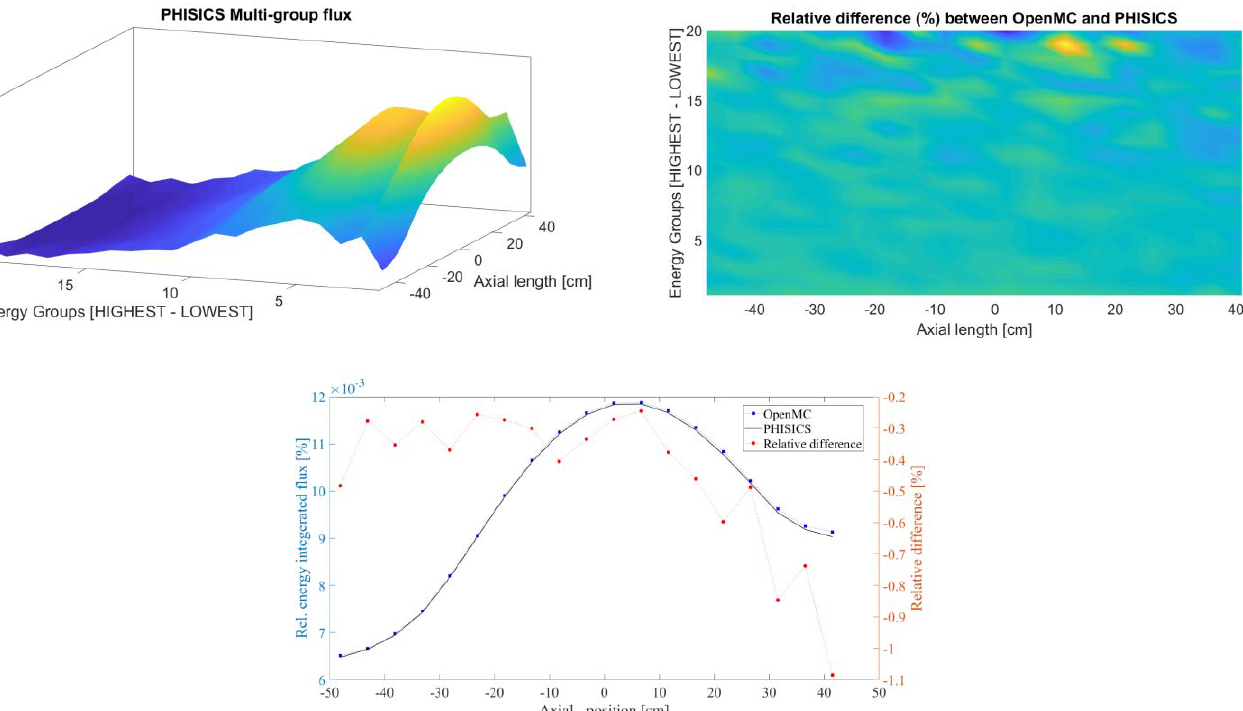
Figure 9. PHISICS vs. OpenMC MGMC benchmark at a peripheral assembly (i.e. reflector